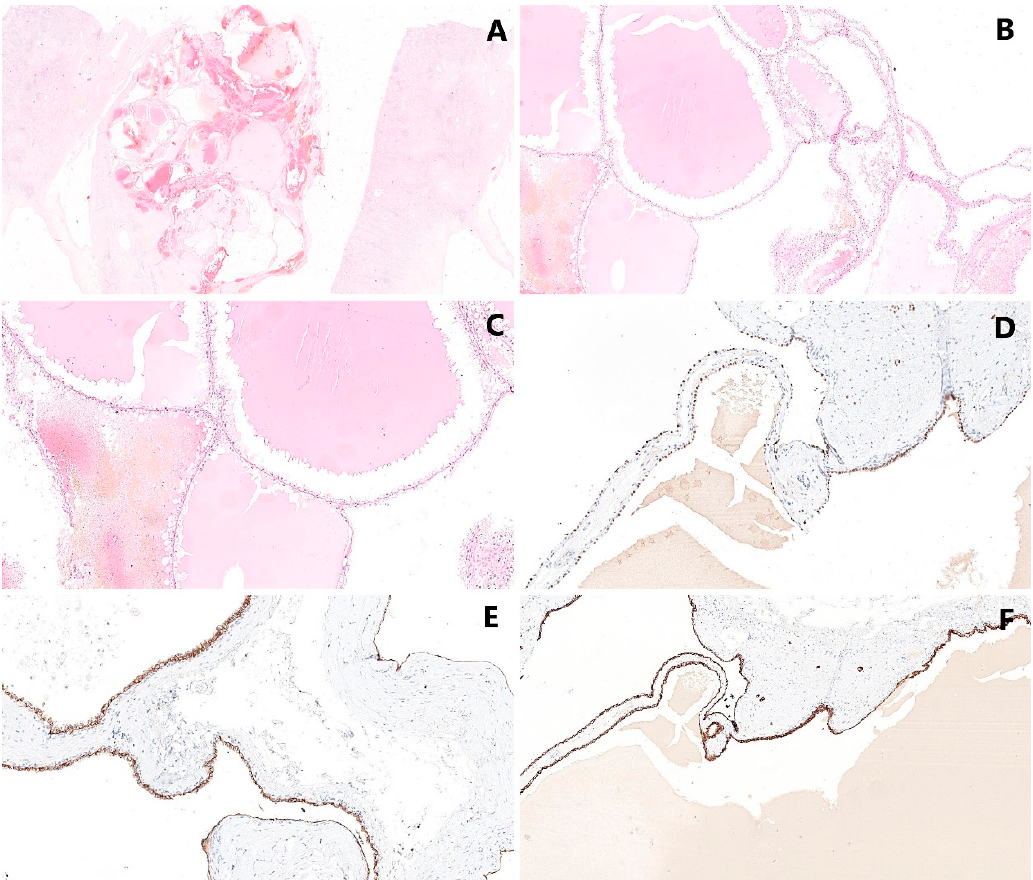
Figure 4. Histological appearance of MCRNLMP: ( A , B ) The lesion is characterized by the formation of cystic spaces— various sized cysts are separated by thin, fibrous septa (magnification 10×, resp. 60×). ( C ) The epithelial lining is composed by neoplastic cells with clear cytoplasm arranged in a single layer (magnification 160×). ( D ) The epithelial lining is positive in PAX8 (magnification 10×). ( E ) Equally, carbonic anhydrase IX (CAIX) shows positivity in neoplastic cells (magnification 10×). ( F ) Strong immunoreactivity was proved in CK7 (magnification